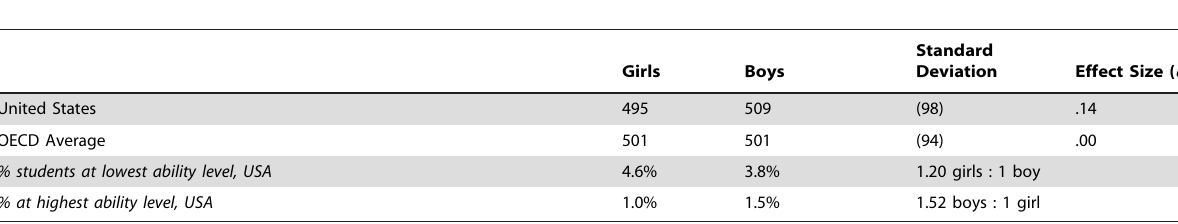
Table 7. US National Science performance for girls and boys, including high and low